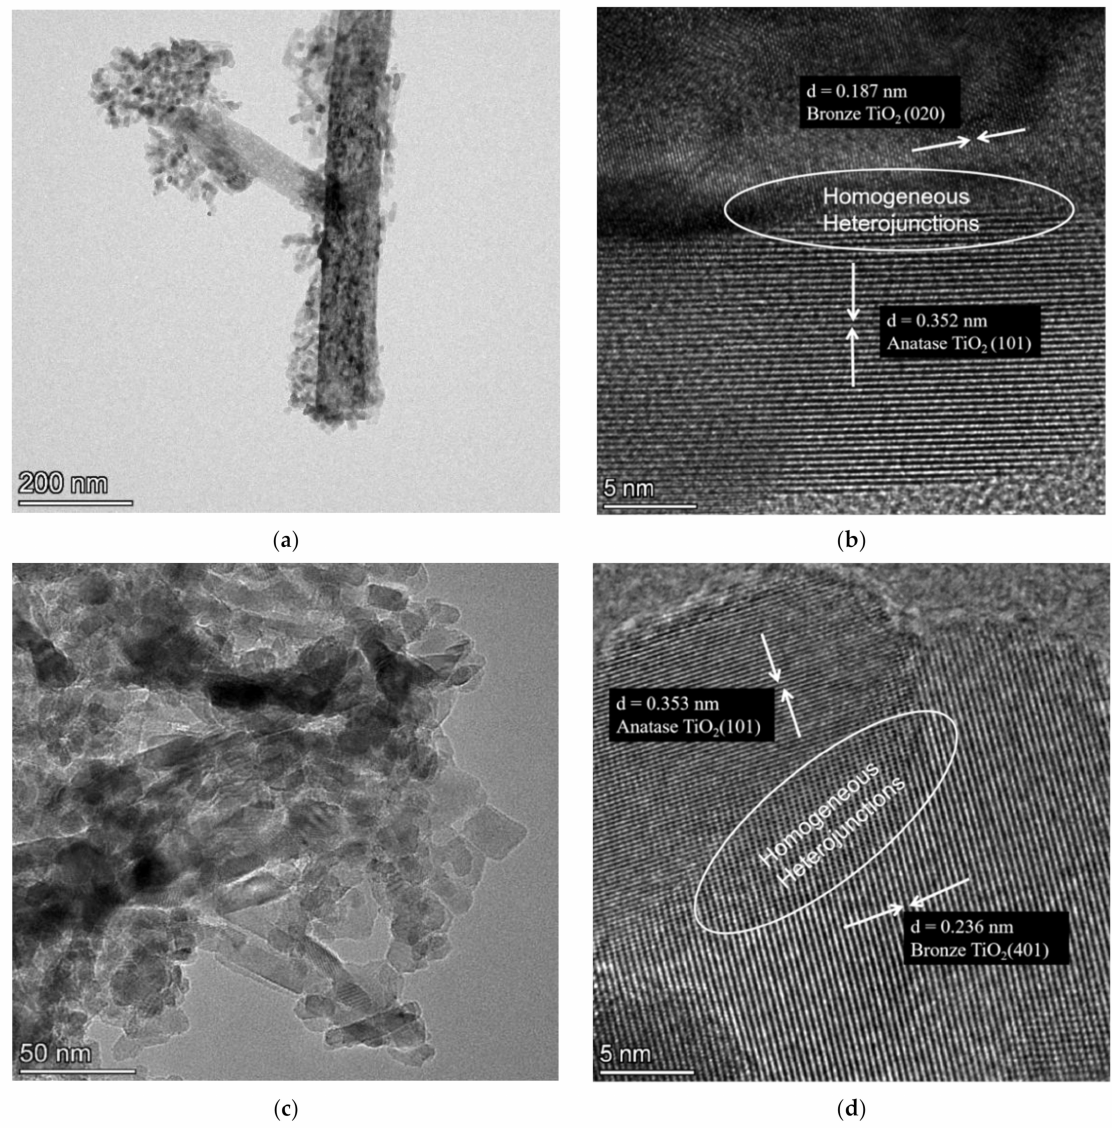
Figure 3. TEM images of the prepared samples: ( a ) DT-190; ( b ) High-resolution image of DT-190; ( c ) DT-180; and ( d ) high-resolution image of